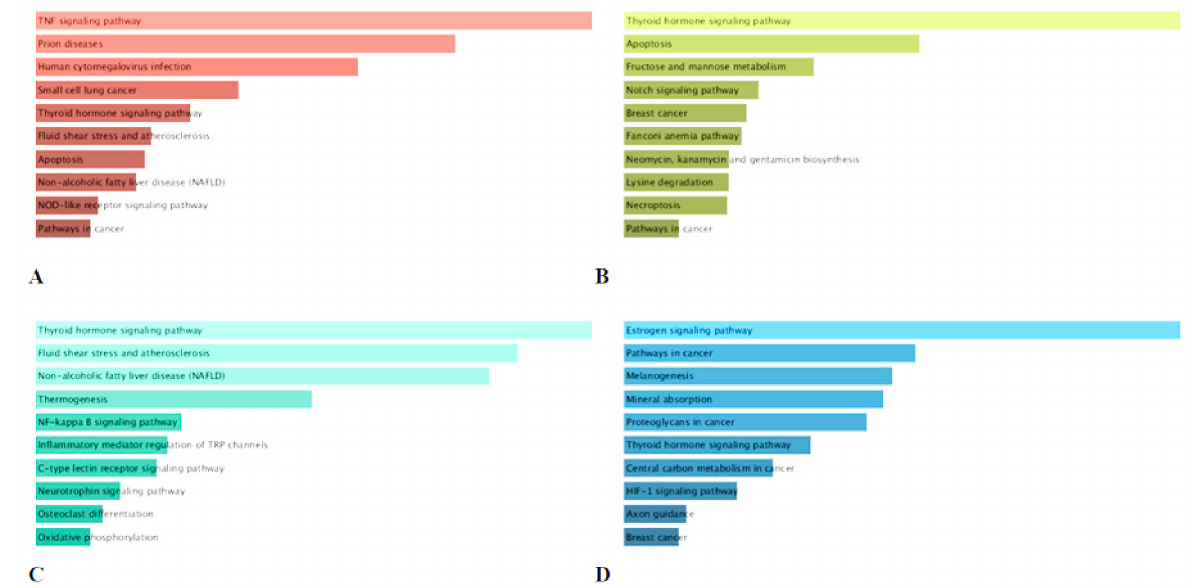
Figure 5. The top 10 KEGG pathway of modulated mRNA (C&D) by the major compounds of Geranium pyrenaicum . ( A ) Corilagin; ( B ) Pedunculagin; ( C ) Tellimagrandin I; ( D ) Ellagic